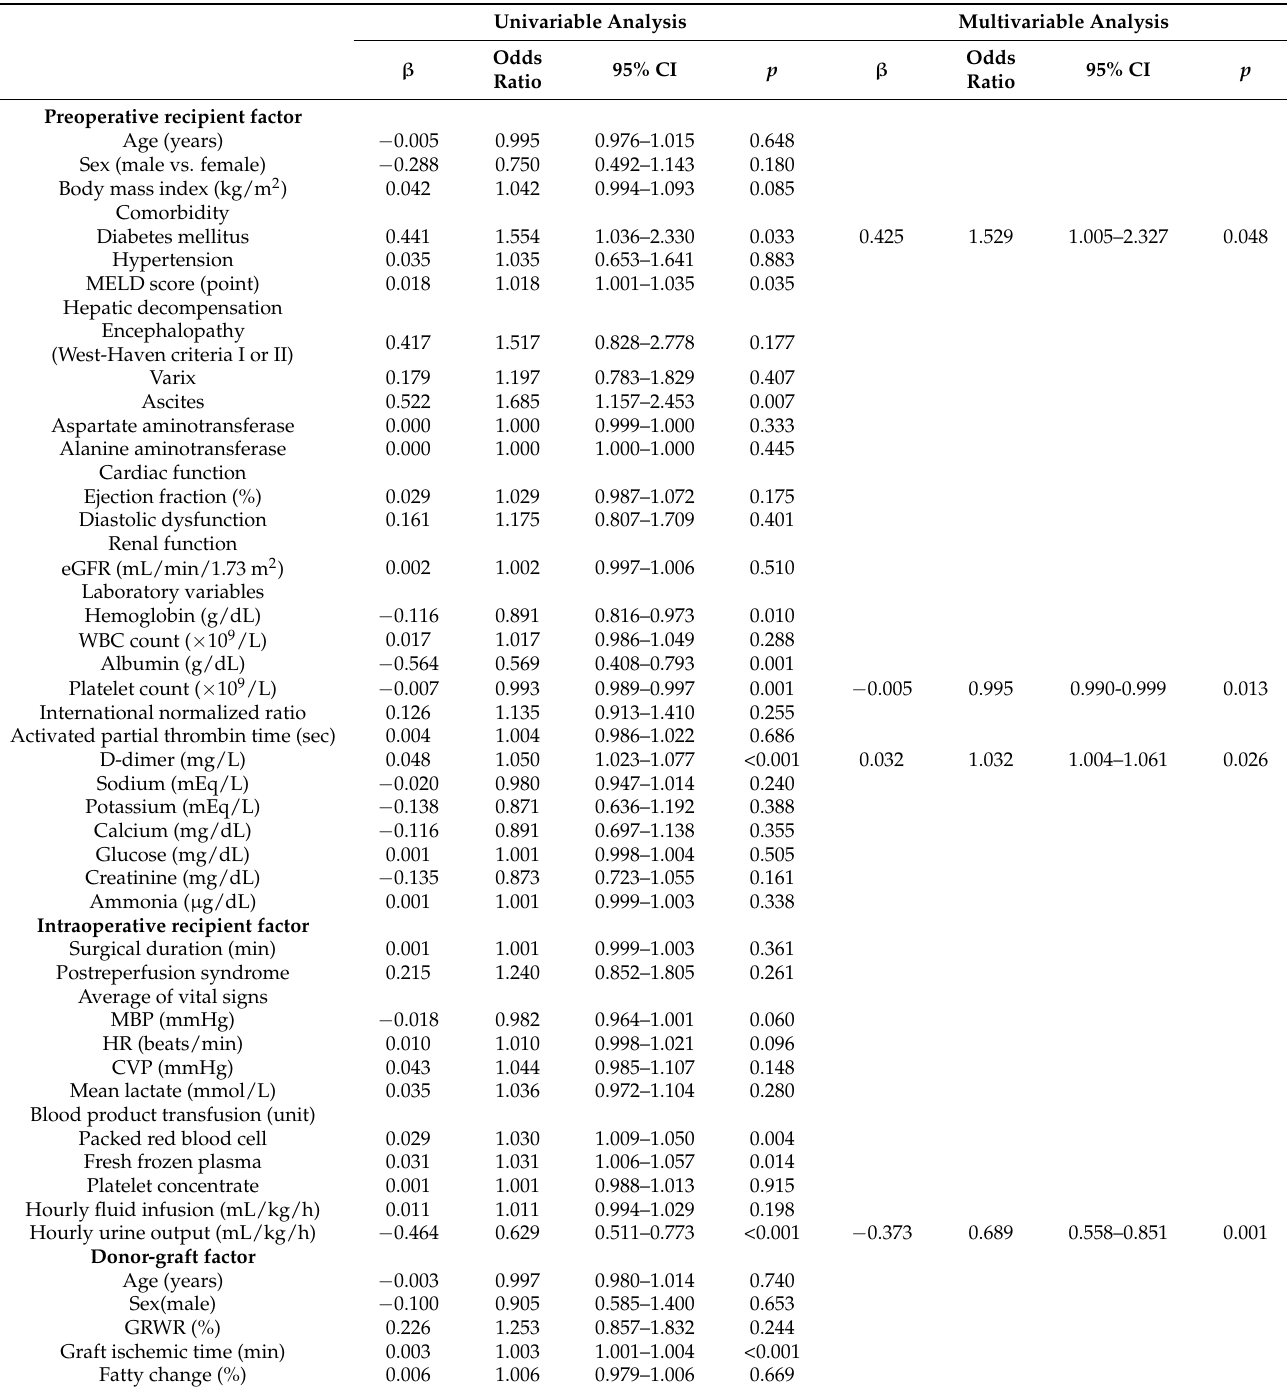
Table 3. Associations of pre- and intraoperative factors with the occurrence of AKI in living donor liver